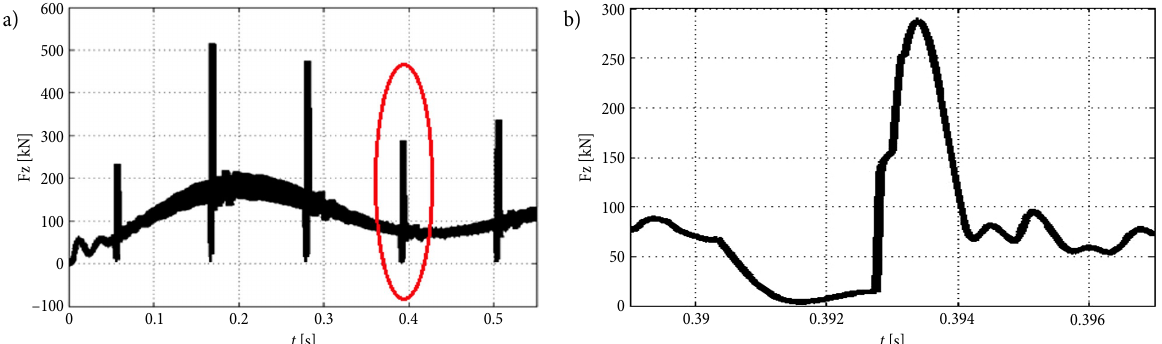
Fig. 10. Changes in vertical force F Z operating upon the wheel over time: a – to 0.55s; b – from 0.388 to 0.398 s